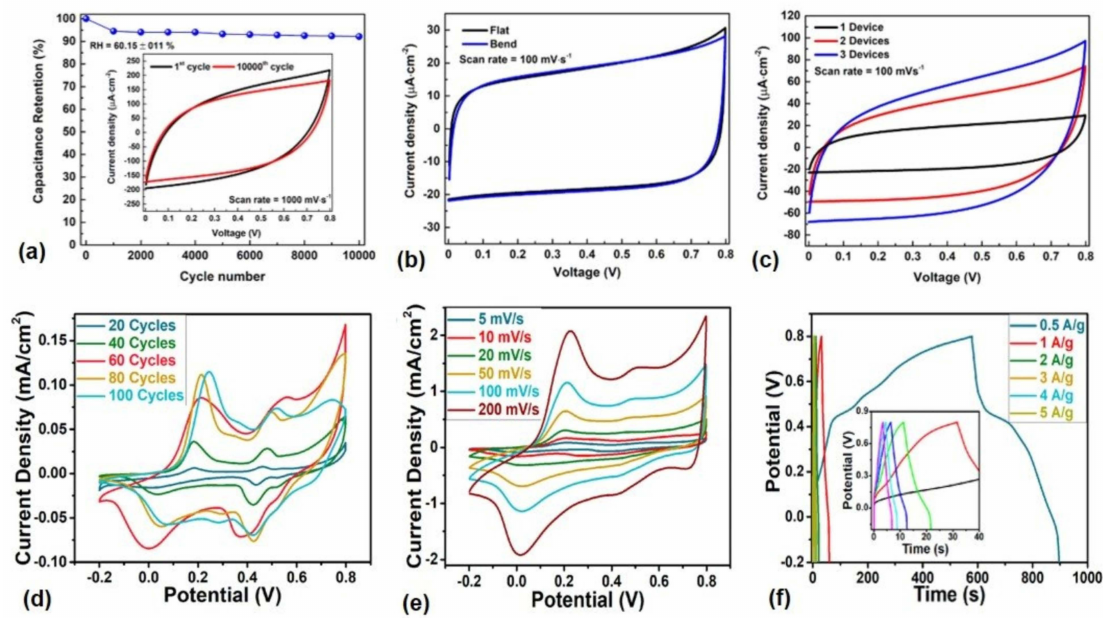
Figure 8. Performance of supercapacitor hydrogel materials from cellulose and its composites. ( a ) the performance of microcrystalline cellulose (MCC)-based supercapacitors under scan rate of 1000 mV/s for 104 CV cycles; ( b ) the CV of the device fabricated based on MCC in bent and flat positions; ( c ) the CV curves of the device at 100 mV/s constructed in parallel; ( d ) CV curve for cellulose based (cellulose from balsa wood) with various deposition cycles at 5 mVs − 1 ; ( e ) CV curves of the composite hydrogel with 60 deposition cycles at 5–200 mVs − 1 composite hydrogels; ( f ) charge-discharge curve of cellulose-based composites using galvanometry. Subfigures ( a – c ) are re-printed with permission under open access license under terms and conditions of the CC BY-NC-ND 4.0 with Ref. [117]; ( d – f ) re-printed with permission under open access license under terms and conditions of the CC BY 4.0 with Ref.